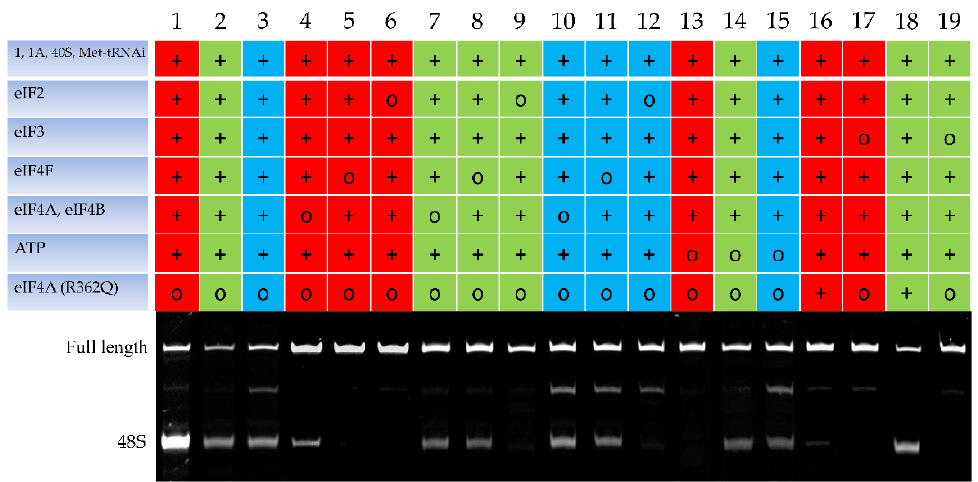
Figure 1. The formation of 48S complexes on capped mRNA with the rabbit beta-globin leader sequence. Toeprinting electropherograms (denaturing 6% PAGE, GelDoc Systems (BioRad, USA) visualization) are presented. Toeprints were detected by fluorescence; the fluorescent dye (FAM) was within the reverse transcription primer. Full-length cDNA and the 48S complex are indicated. The addition of components is denoted as +, their absence as 0. Red lanes, capped unmodified mRNA; green lanes, capped m 6 A-modified mRNA; azure lanes, uncapped m 6 A-modified mRNA. Detailed examination of toeprinting electropherograms (lanes 3, 10, 11, 12, and 15) revealed additional bands between the 5 ′ and 3 ′ ends of modified mRNA. These stops in reverse transcription were observed previously and associated with the presence of a stretch of adjacent modified nucleotides m 6 A(4) [24], which were poorly recognized by the reverse transcriptase and caused the termination of re- verse-transcription elongation.